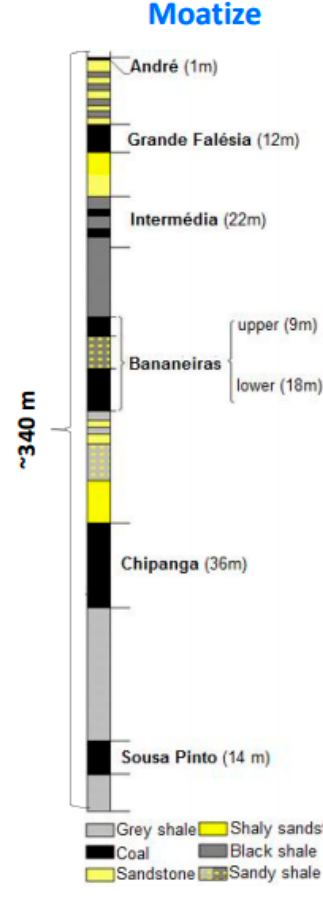
Figure 1. Moatize basin [8].